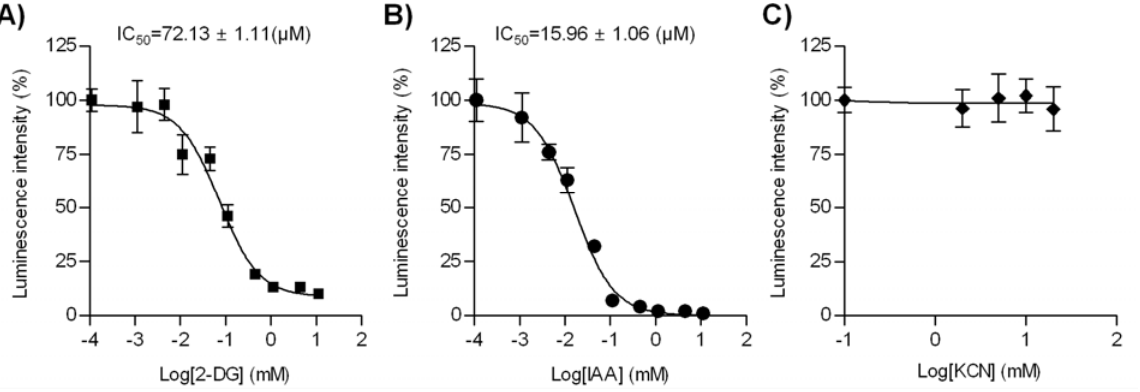
Figure 5. Kinetic analysis of the glycolysis inhibitors 2-DG ( A ) and IAA ( B ), and KCN ( C ). HeLa cells were incubated in glucose-free Ringer solution containing the inhibitor for 1 h, and the luminescence signal (p/s) was recorded 5 min after PTD-Luc treatment (40 nM). The results are expressed as the average percentage luminescence signal relative to the control (no inhibitor). Symbols represent the mean ± SEM, and lines represent the linear data fit. is given in the plot area. The data were collected from four samples in three The IC 50 independent